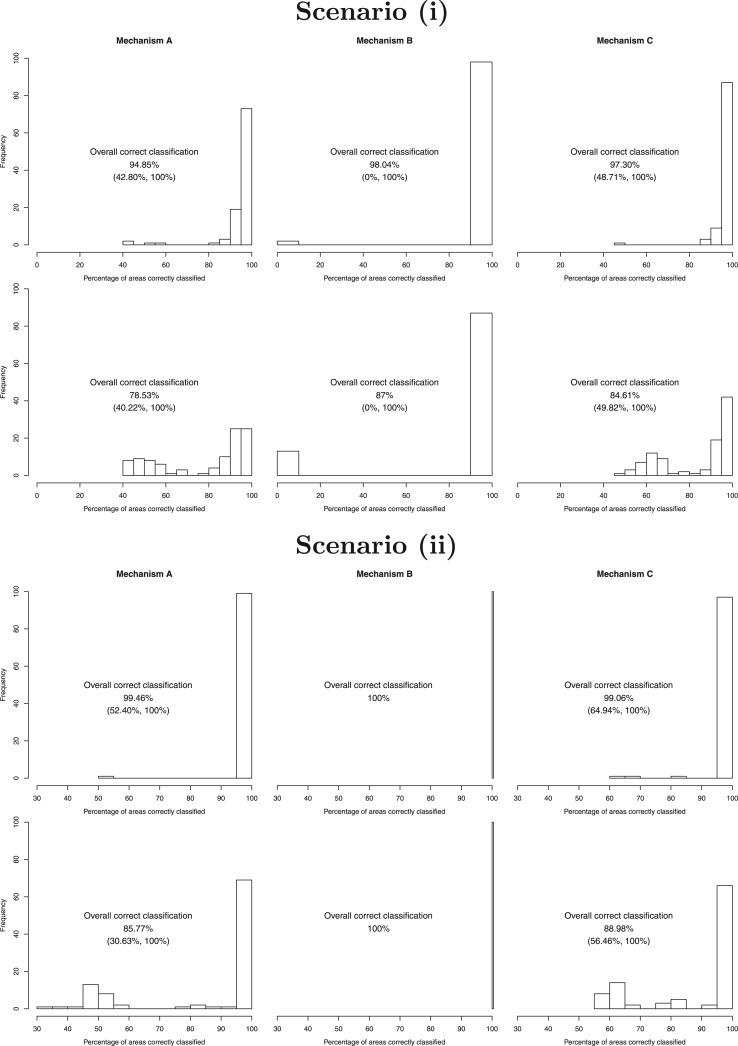
Histograms showing the percentage of areas allocated to the correct trend for each simulated data set in scenarios (i) (top) and (ii) (bottom). In each case, the top row relates to the (MC)\documentclass[12pt]{minimal}
\usepackage{amsmath}
\usepackage{wasysym} 
\usepackage{amsfonts} 
\usepackage{amssymb} 
\usepackage{amsbsy}
\usepackage{upgreek}
\usepackage{mathrsfs}
\setlength{\oddsidemargin}{-69pt}
\begin{document}
}{}$^{3}$\end{document} algorithm, and the bottom row relates to the standard MCMC algorithm. The numbers give the overall (all 100 data sets) correct classification percentages and the lowest and highest values for a single data set.